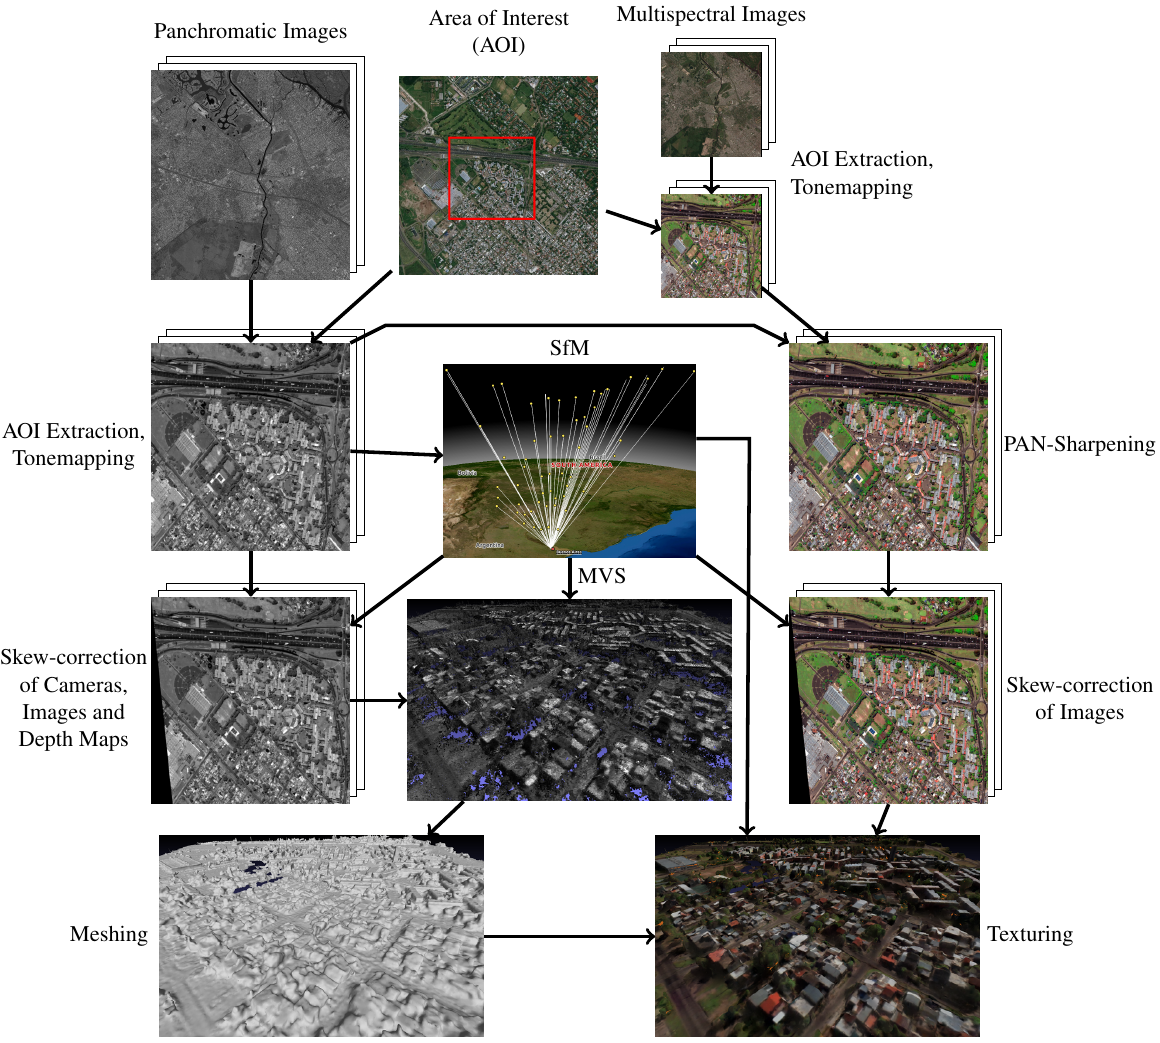
Figure 1. Pipeline overview including the different components, the corresponding results and their computational dependencies. As input the pipeline receives a set of panchromatic and multispectral images as well as a bounding box defining the area of